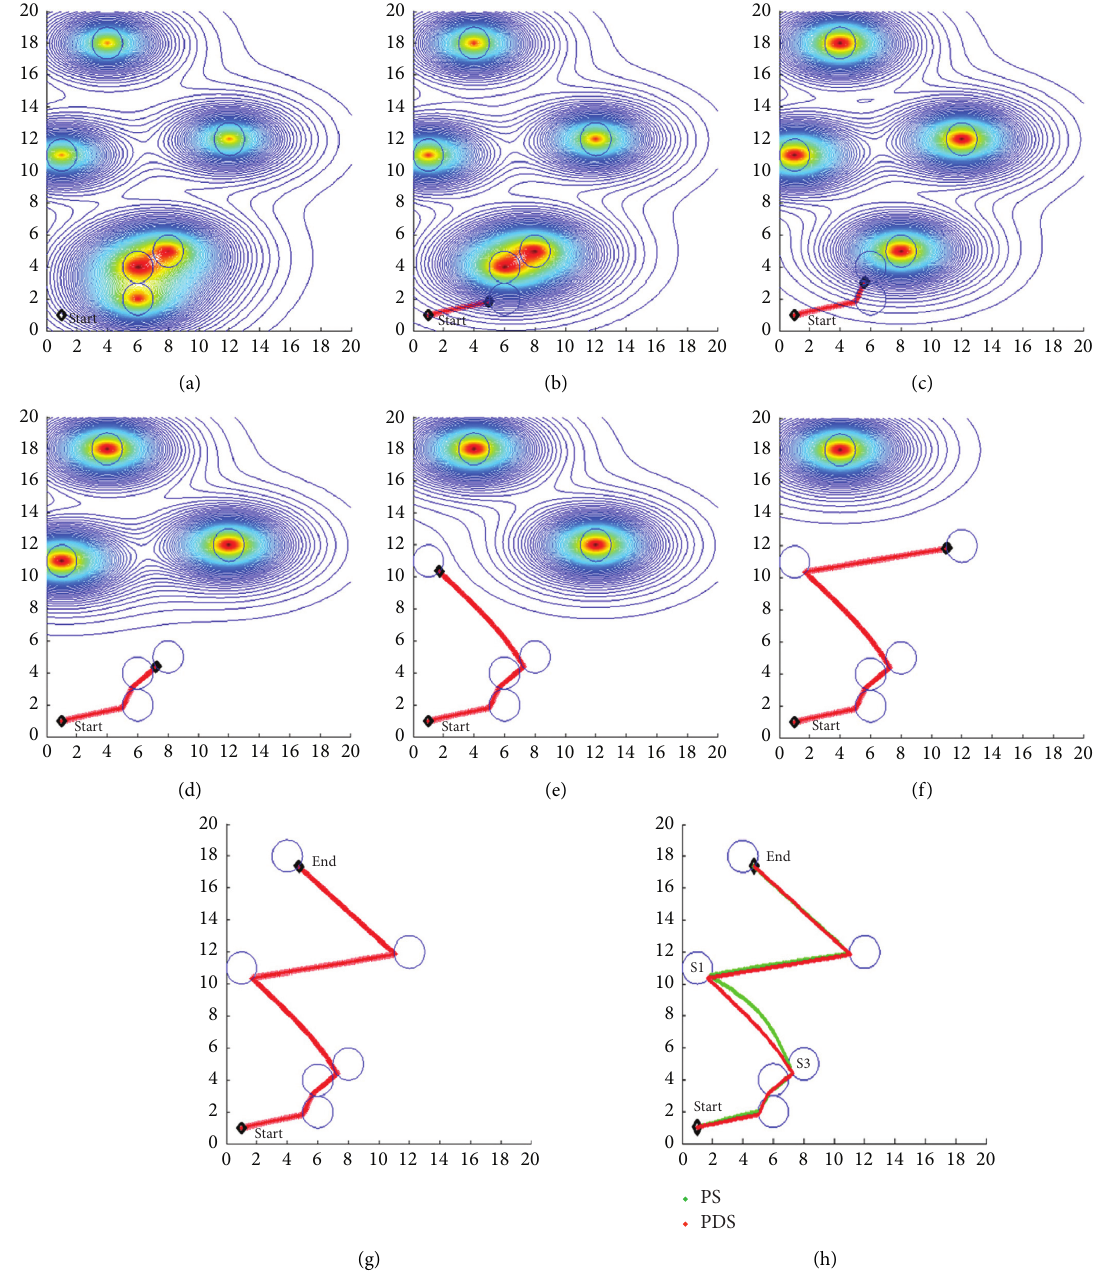
Figure 4: Process of generating the trajectory for PDS under sources with Gaussian-like shape field intensity distribution. (a–g) Access sequence and how a trajectory is built. (a) t � 0, (b) t � 43, (c) t � 52 (d) t � 72, (e) t � 156, (f) t � 249, (g) t � 333, (h) Trajectory comparison between PS and